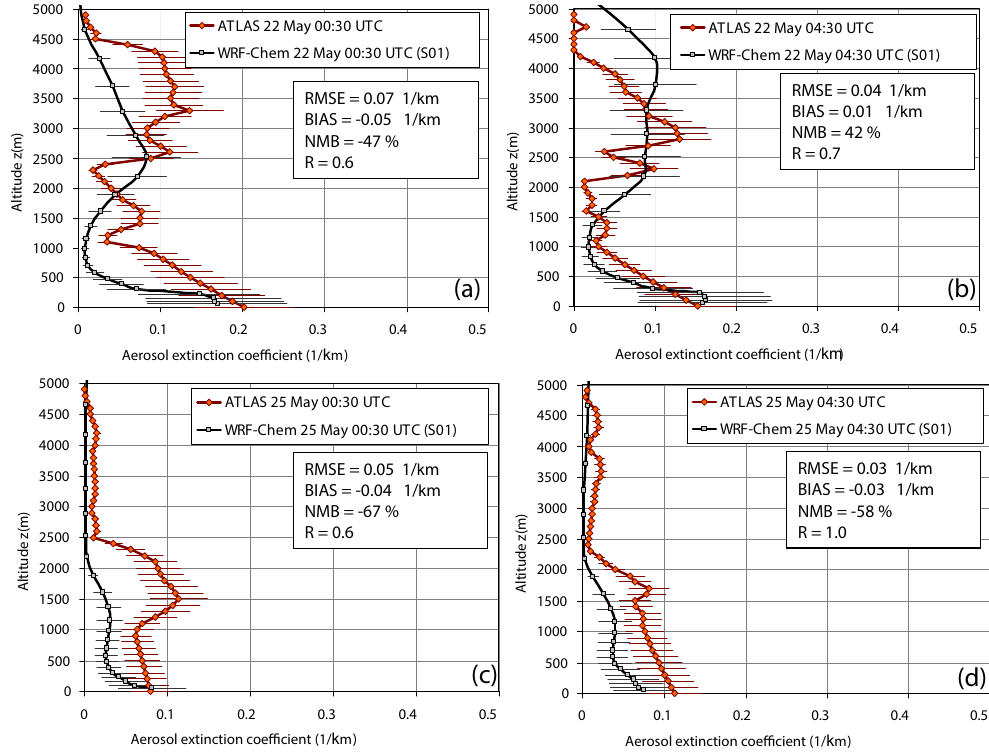
Figure 8. Vertical profiles (0–5km, y axis) of the 1h mean aerosol extinction coefficient (km − 1 ) in Rome as retrieved by the ATLAS lidar data (at 532nm, red line, orange diamonds) and simulated by the WRF-Chem (S01) model (at 550nm, black line, gray squares). Error bars associated with the lidar data represent an expected 30% error in the lidar retrieval (see text), while a 50% error bar has been associated with the model values. Top (a, b) and bottom (c, d) panels refer to 22 and 25 May, respectively. Left (a, c) and right (b, d) column panels refer to profiles at 00:30 and 04:30UTC,